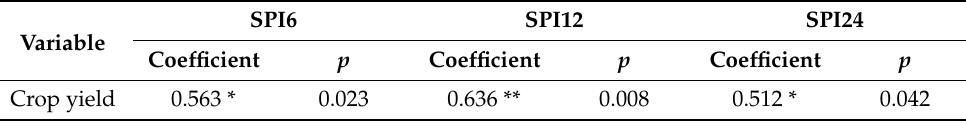
Table 2. The correlation coefficients between SPI6-24 and crop yield in Yuzhong county. SPI6 SPI12 SPI24 Variable Coefficient p Coefficient p Coefficient p Crop yield 0.563 * 0.023 0.636 ** 0.008 0.512 * 0.042